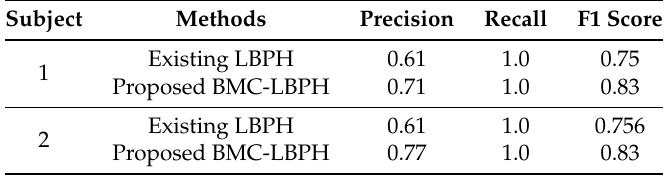
Table 5. LBPH and BMC-LBPH FR techniques performance in rainy weather.